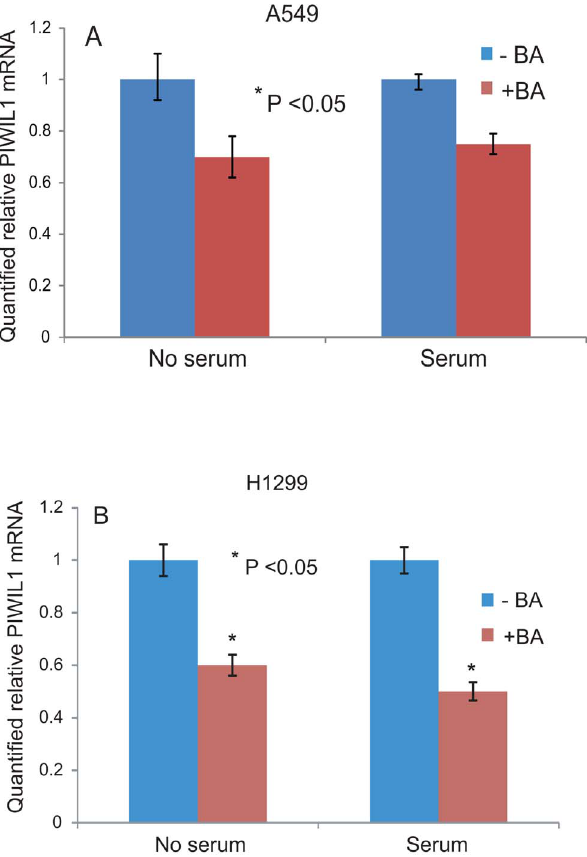
Figure 4 . RASSF1C decreases the sensitivity of lung cancer cells to betulinic acid. A549 (A) and NCI-H1299 (B) lung cancer cells over- expressing RASSF1C were treated with betulinic acid (BA) for 24 h. Cells were then assayed for cell viability/proliferation. RASSF1C over- expression significantly reduced the sensitivity of cells to BA. Data is representative of at least 3 independent experiments, and the values represent the mean 6 SEM. * P , 0.05: for 1C compared to BB.